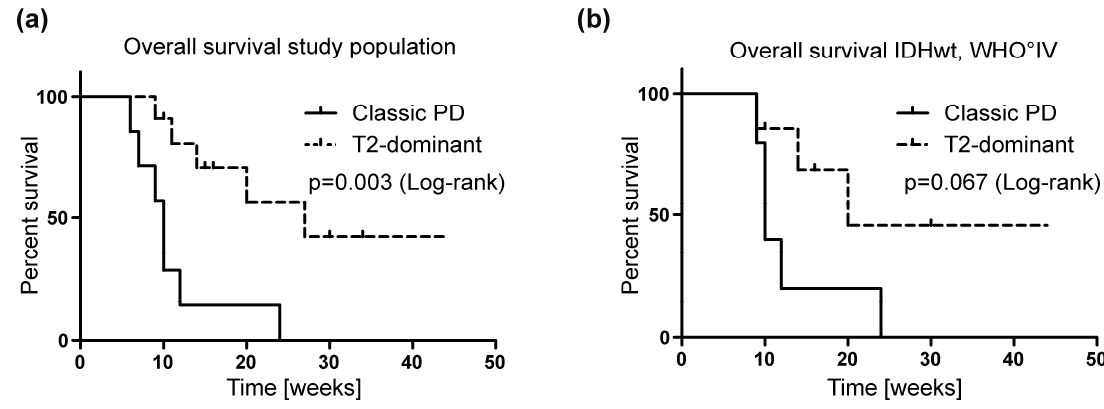
Figure 3. Association of magnetic resonance imaging (MRI) progression patterns with overall survival. Kaplan-Meier survival curves were obtained by discriminating classic progressive disease (PD) in contrast to T2-dominant growth patterns (T2-dominant) in MRI as indicated in the figure. Curves were compared by log-rank (Mantel-Cox) test ( p -values depicted). ( a ) Overall survival for patients with classic PD ( n = 7) and T2-dominant growth pattern ( n = 11) (median 10 vs. 27 weeks). ( b ) Overall survival for the subcohort of patients with IDH-wildtype (wt) WHO IV glioblastoma (classic PD n = 5, T2-dominant growth pattern n = 7) (median 10 vs. 20 weeks).